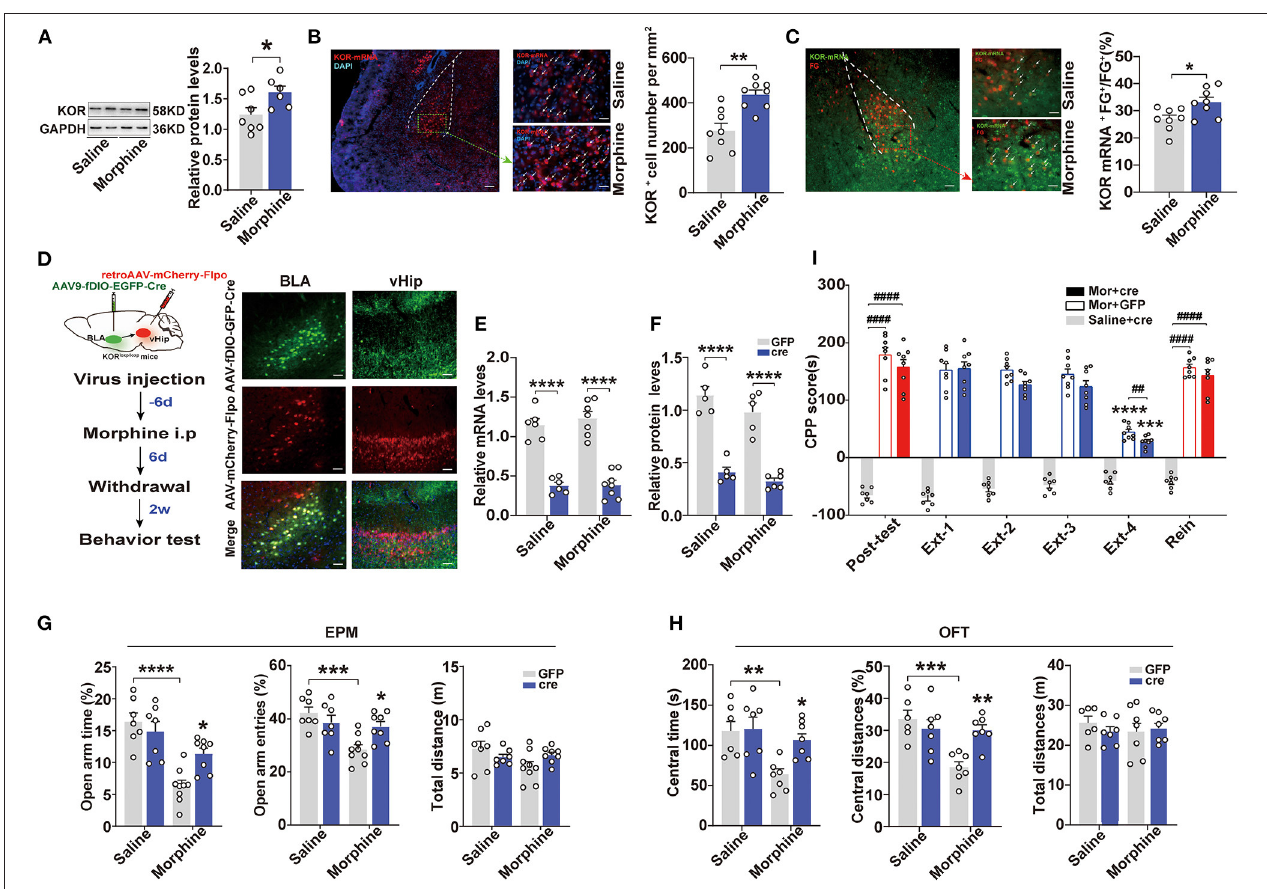
FIGURE 4 | Specific knockdown of the kappa opioid receptor in the BLA to vHip projections ameliorate anxiety-like behaviors in morphine-withdrawn mice. (A) Immunoblots and quantification analysis of KOR levels in the BLA. KOR protein expression levels increased in the BLA of the Mor-A mice. (B) (Left) Representative images of KOR mRNA (red) in the BLA of the Mor-A mice. The nuclei were stained with DAPI (blue). Scale bar: 200 µ m. BLA regions enclosed by a green box are shown at higher magnification in images to the right. Scale bars: 50 µ m. (Right) KOR + cell numbers per mm 2 in the BLA of the Mor-A mice were increased. (C) Co-labeled neurons for KOR mRNA and FG in the BLA. Retrograde FG was injected into the vHip. (Left) Representative images of KOR mRNA (green) and fluorogold (FG; red) immunostaining in the BLA. Scale bar: 200 µ m. BLA regions enclosed by a red box are shown at higher magnification in the images to the right. Arrows indicate neurons co-labeled with FG and KOR mRNA. Scale bars: 50 µ m. (Right) The percentage of neurons co-labeled with KOR mRNA and FG relative to FG in the BLA. (D) (Left) Schematic of the KOR knockdown from the BLA to vHip projections in the KOR loxp / loxp mice. (Right) Representative coronal images of virus injection in the BLA and vHip. Scale bar: 100 µ m (E) KOR mRNA and (F) KOR protein expression levels in the BLA of the KOR loxp / loxp mice with Cre-recombinase expression were decreased. (G) The Mor-A mice with KOR knockdown exhibited increases in open-arm time and entries in the EPM. (H) The Mor-A mice with KOR knockdown exhibited increases in central time and central distances in the OFT. (I) Knockdown of KOR in the BLA to vHip projections did not affect the morphine CPP. Data are expressed as the mean ± SEM. The KOR knockdown experiment compared the Mor-A mice expressing Cre-recombinase with Mor-A mice expressing GFP. In the CPP results, *: comparison between the extinction group and the post-test group. #: comparison between the 2 indicated groups. n = 6–8/group. * P < 0.05, ** P < 0.01, *** P < 0.001, **** P < 0.0001; ## P < 0.01, #### P <